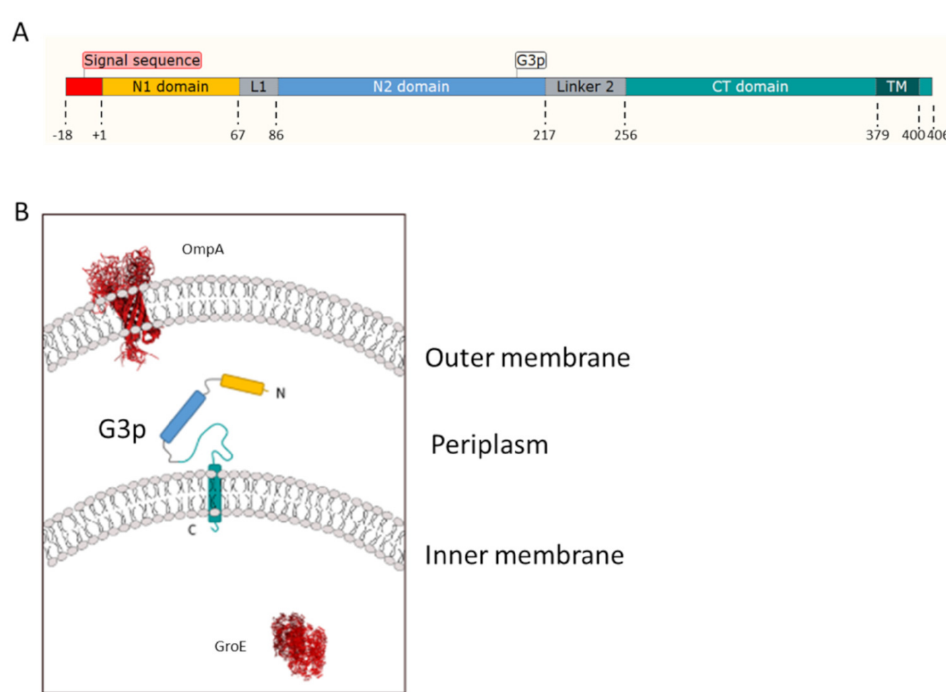
Figure 1. Structural features and topology of G3p. ( A ) Schematic representation of the G3p protein regions with the signal sequence (red, residues − 18 to − 1), the N1 domain (yellow, residues 1 to 67), the linker 1 region (grey), the N2 domain (blue, residues 86 to 217), the linker 2 region (grey) and the CT domain (green, residues 256 to 406), which includes the membrane anchor segment (380 to 400) and the cytoplasmic domain (residues 401 to 406). ( B ) Topology of the G3p protein domains in the periplasm and spanning the inner membrane using the same colour code as in ( A ). Depicted are the outer membrane OmpA and the cytoplasm GroE (in red) that were used in the localisation studies as control